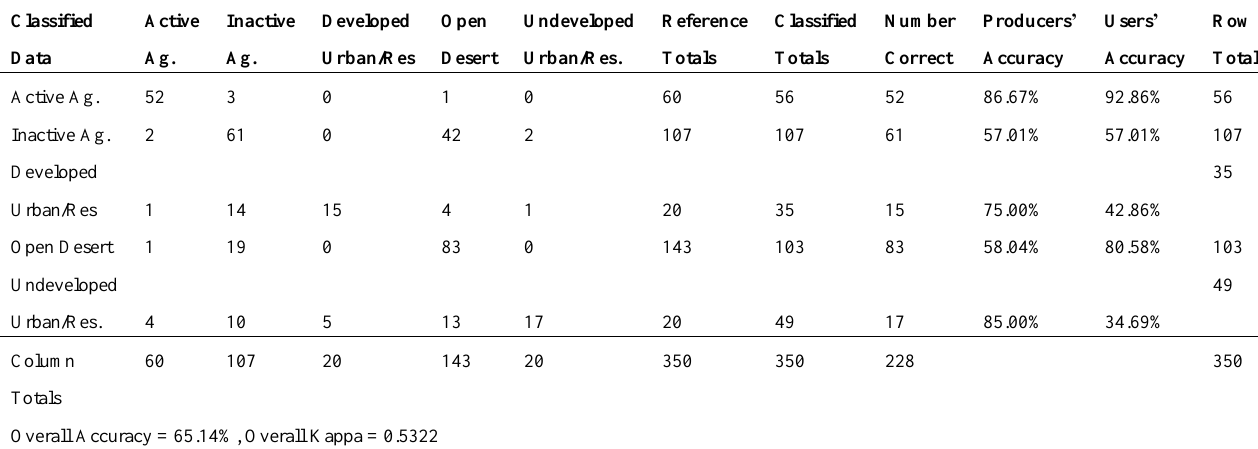
Table 3. Error matrix and classification accuracy—Unsupervised